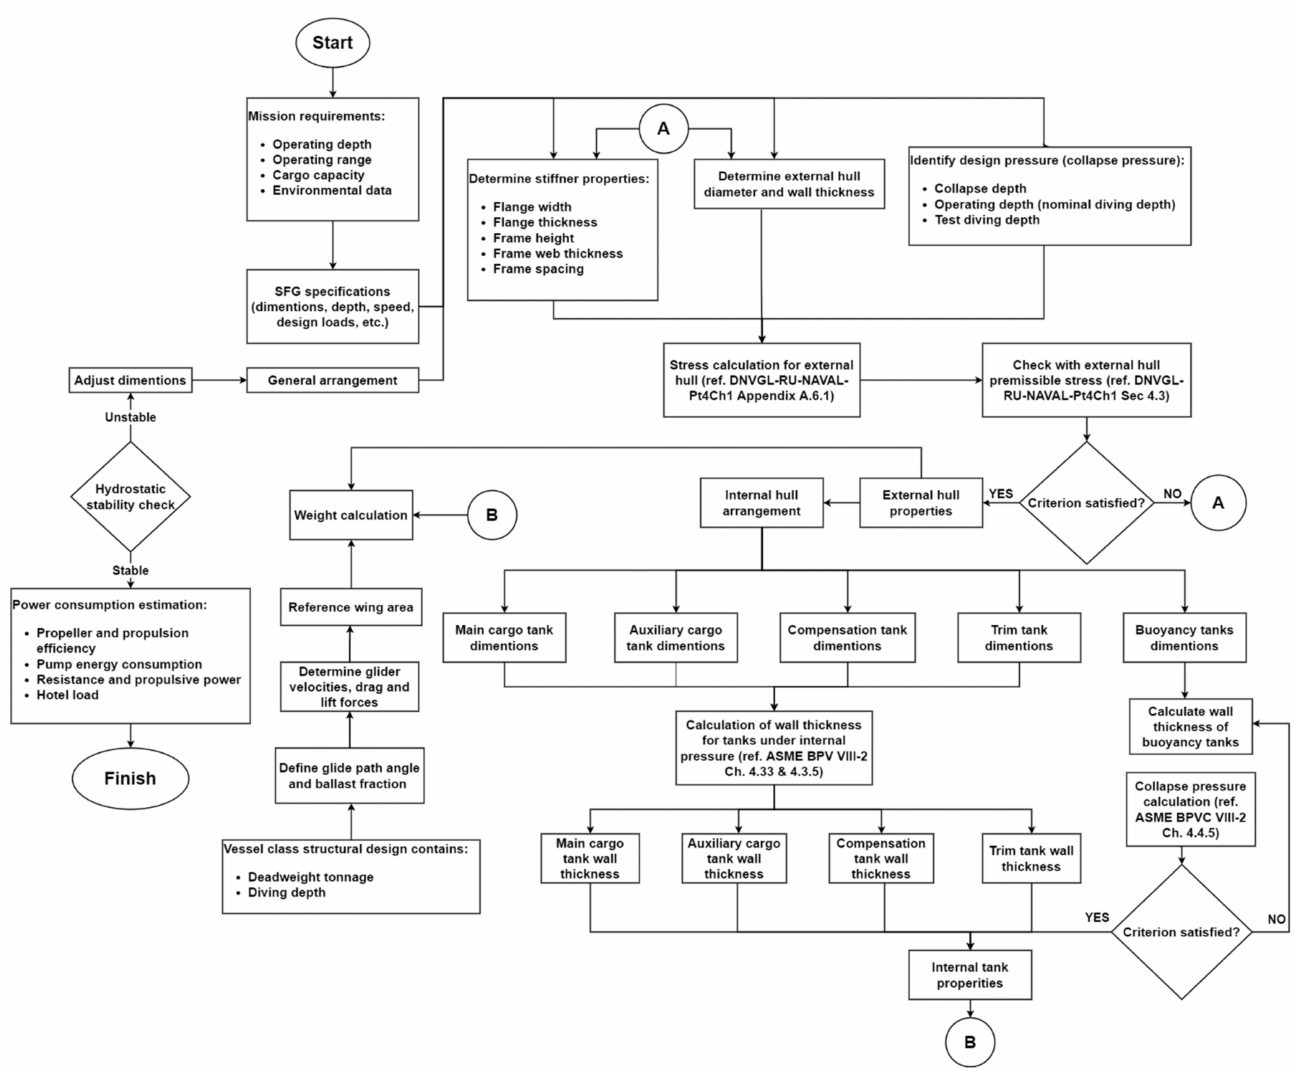
Figure 2. Flow chart of the SFG technical